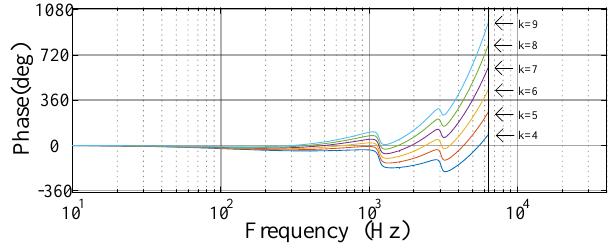
Figure 17. Phase correction effect of z k to S(z)P(z) .